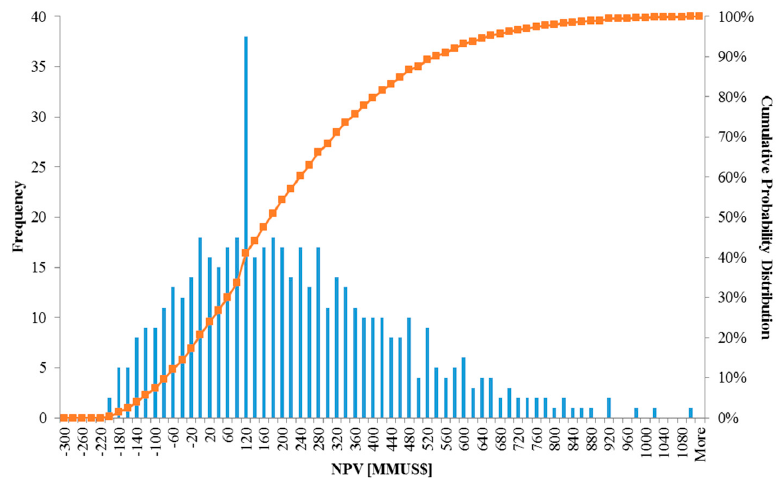
Figure 9. Histogram and cumulative probability function for two-stage stochastic model.